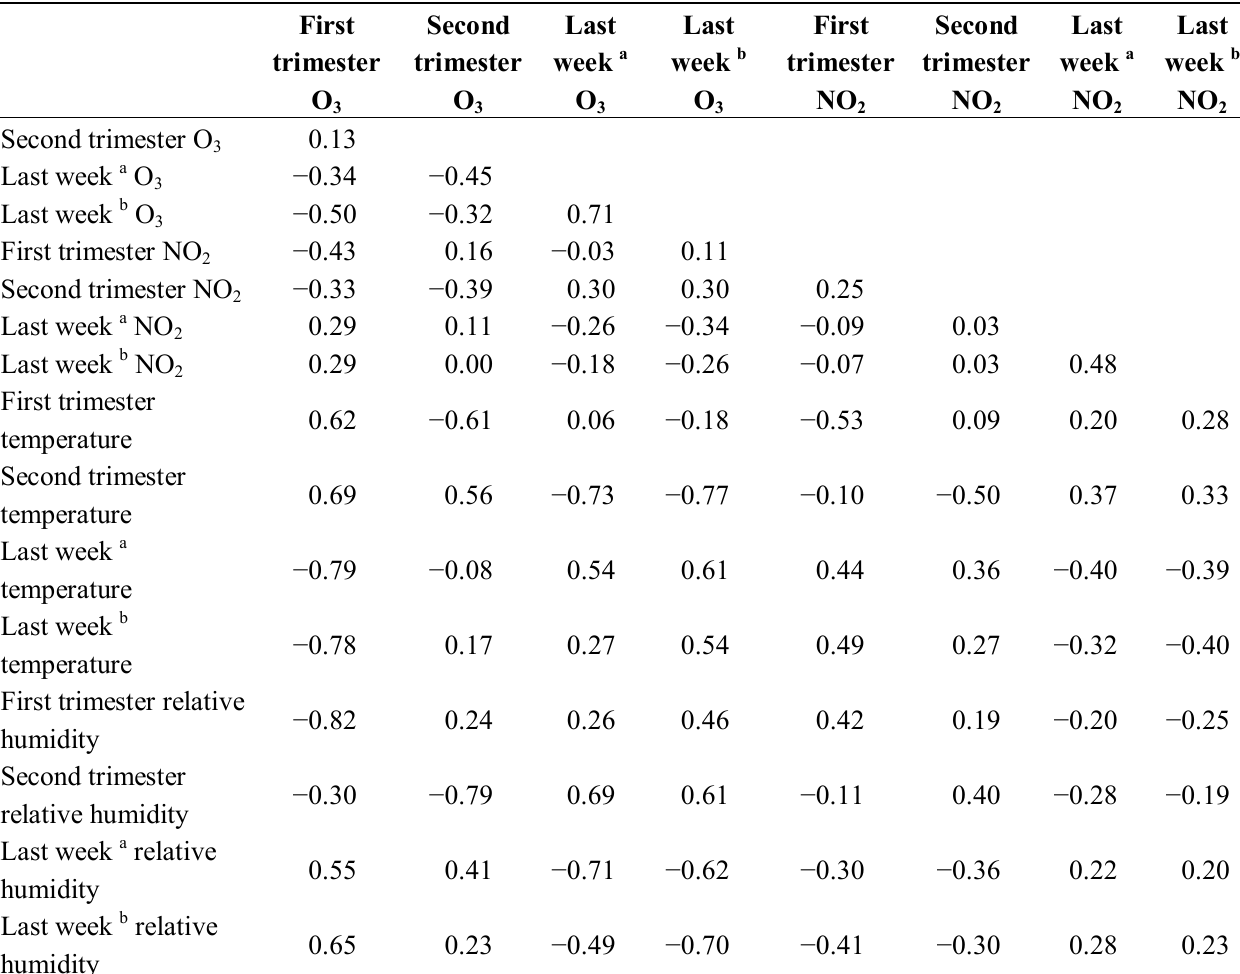
, NO and meteorological 3 2